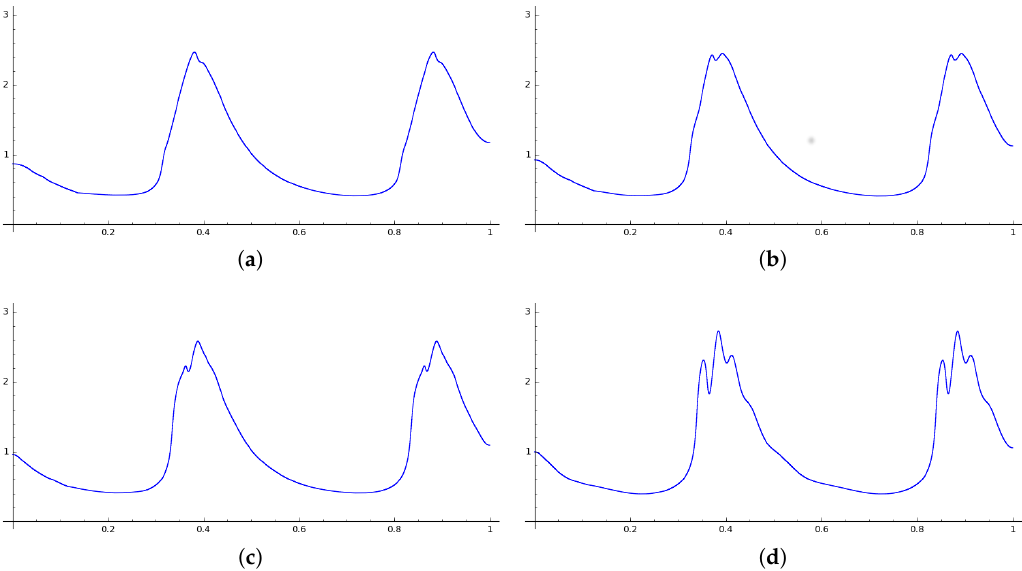
Figure 4. Approximated stationary densities f ξ , δ for T ξ , with δ = 2 − 19 and A = 0.07. ( a ) ξ = 0.732 × 10 − 1 ; ( b ) ξ = 0.488 × 10 − 1 ; ( c ) ξ = 0.305 × 10 − 1 ; ( d ) ξ = 0.214 × 10 − 1